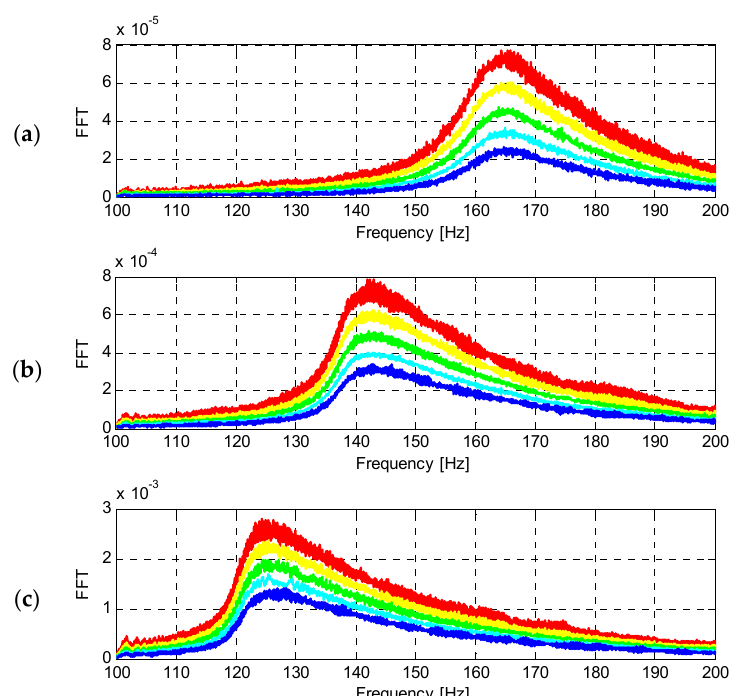
Figure 31. Power spectral density of the results from the additional accelerometers. Material: saclSi 1; Isotropic pressure 50 kPa; Frequency spectrum 100–250 Hz; Excitation (torque) amplitude: ( a ) 0.5 V, ( b ) 2 V, ( c ) 4 V (– the top sensor, S1, – the second sensor from the top, S2, – the third sensor from the top, S3, – the fourth sensor from the top, S4, – the bottom sensor, S5).